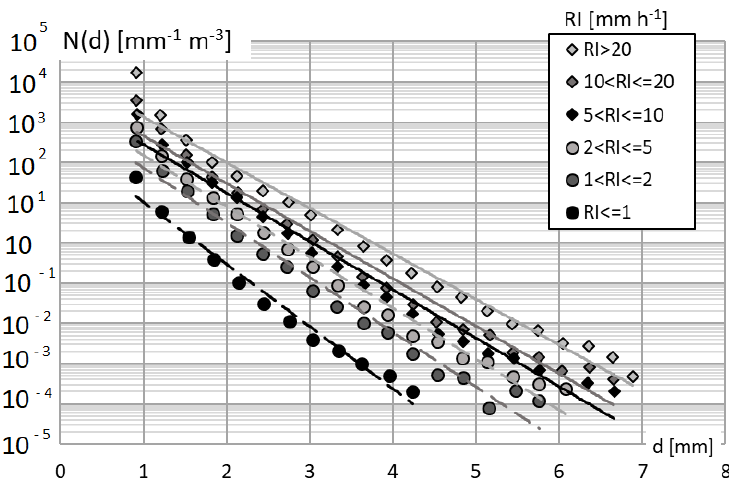
Figure 4. Measured PSD data from [27] and the associated best-fit exponential functions obtained for each rainfall intensity class. Table 2. Parameters N 0 and Λ of the MP distribution and the associated correlation factors for each rainfall intensity class, as obtained by fitting the measured PSD data provided by [27].